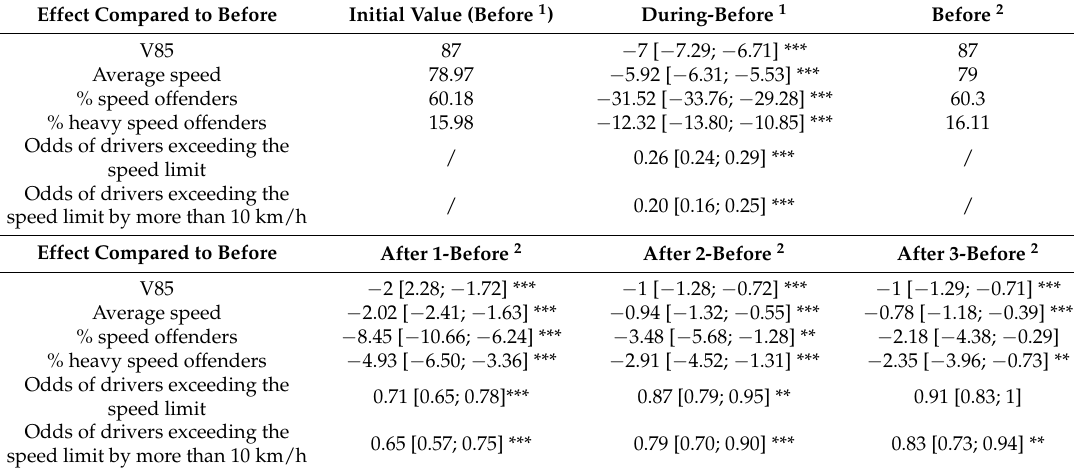
Table 4. Results for the overall effects in regional police unit 2.